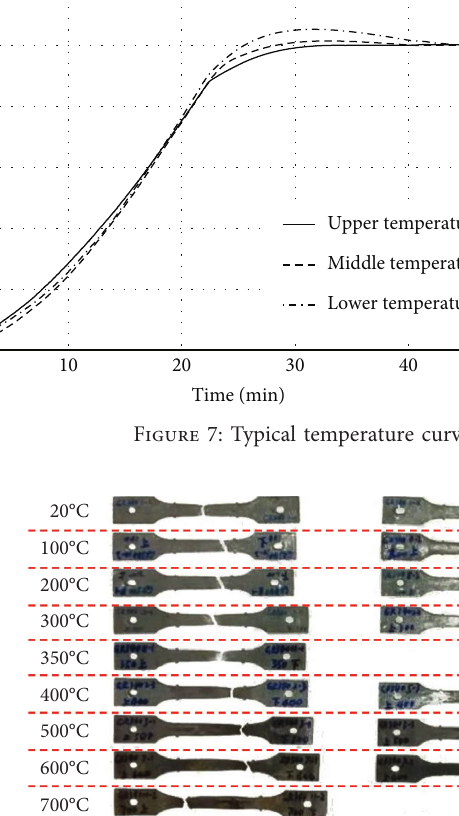
Figure 8: Failure modes for S350 steels.